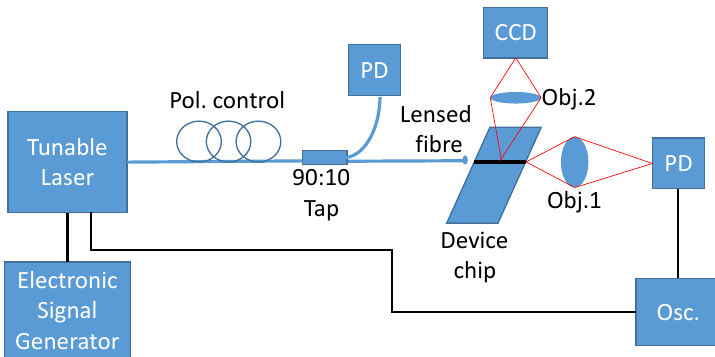
Figure 3. Schematic of the measurement setup. Obj.1 and 2 are objective lenses for imaging the device facet and top surface respectively, PD are photodiodes and Osc. is a digital oscilloscope. CCD is an InGaAs CCD camera.